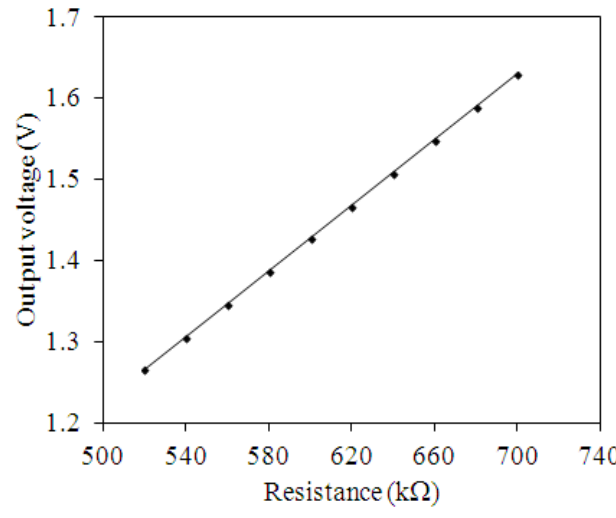
Figure 3. Simulated readout of the output voltage for the readout circuit.